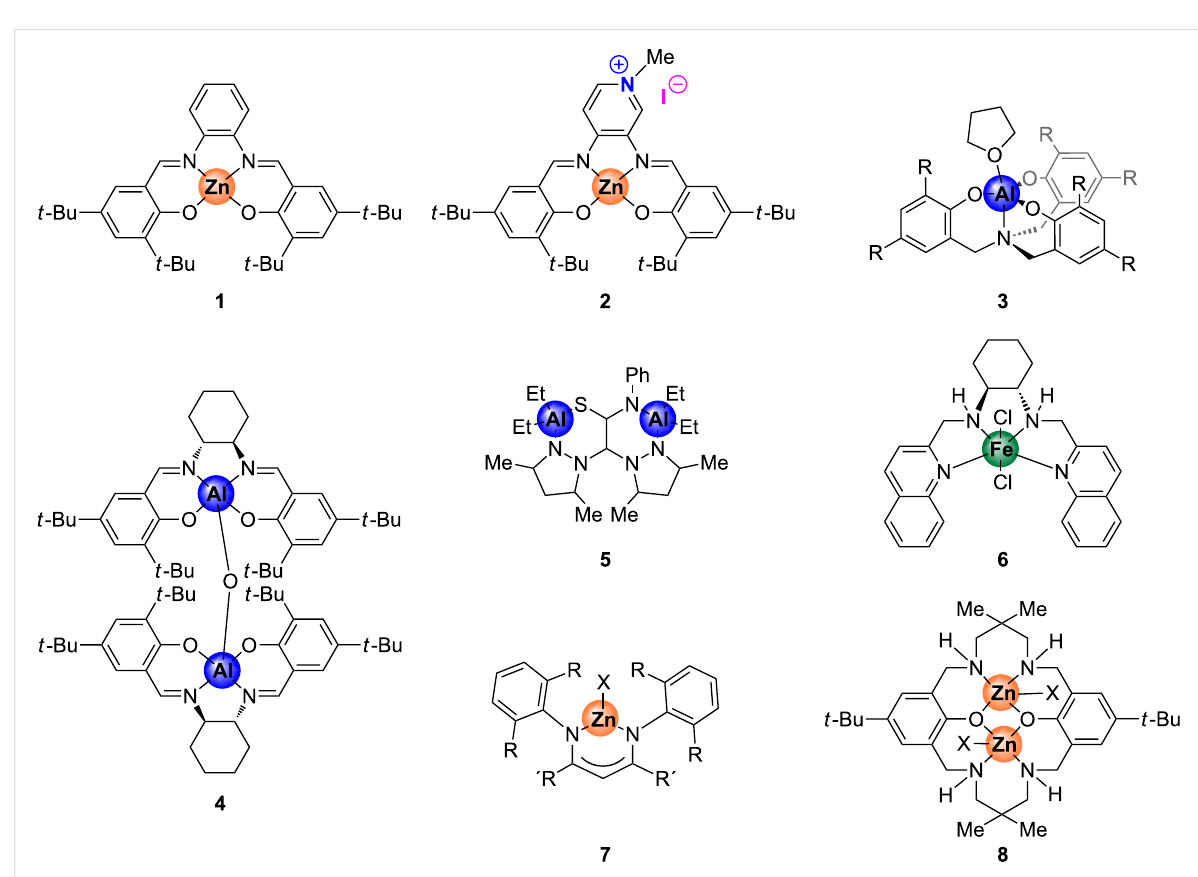
Figure 1: Structures of some metal complexes used as catalyst for (cyclic) organic carbonate